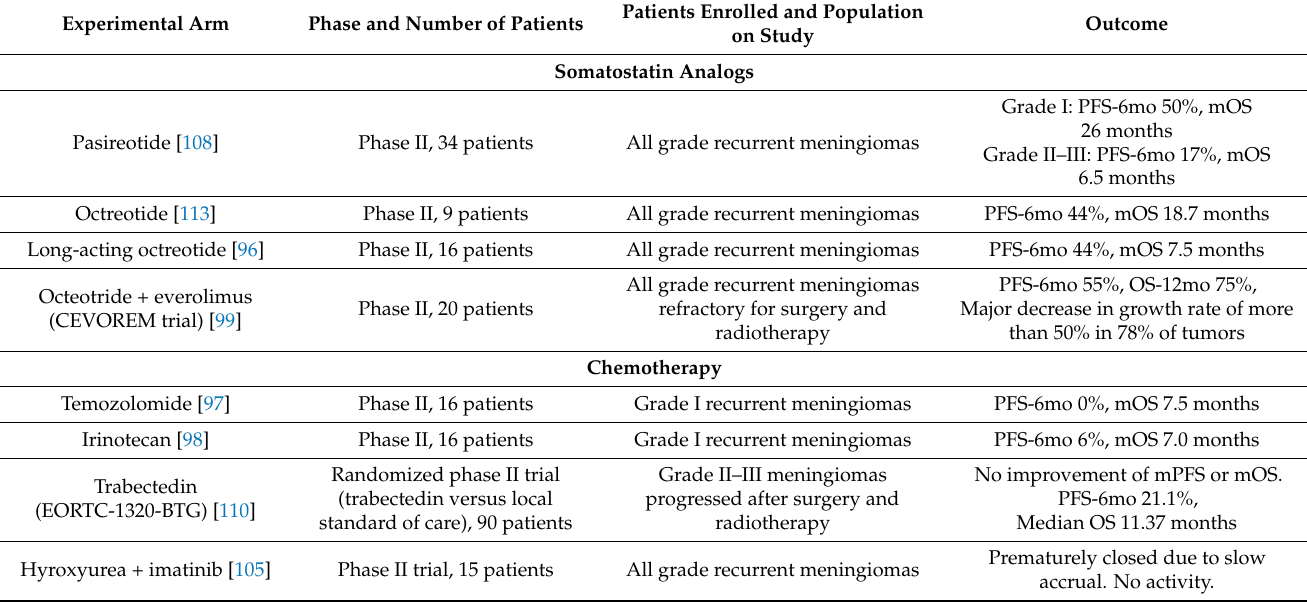
Table 2. Prospective clinical trials investigating systemic treatments on meningioma. mOS: